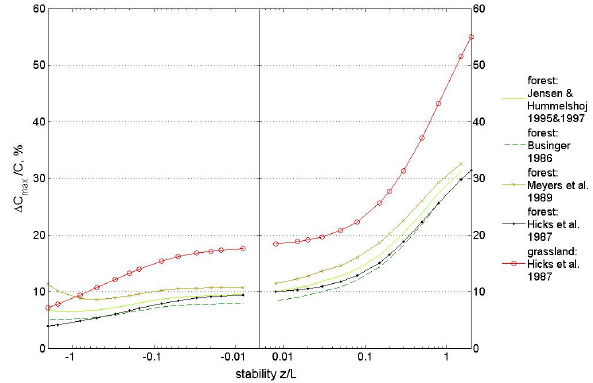
Fig. 2. Minimal relative precision requirements ( 1C max / C in %) assuming a maximum HNO 3 deposition flux ( R c =0) for a grassland site (NEU) and a forest site (EGER). For the forest site different pa- rameterizations for R b existing in literature (Businger, 1986; Jensen and Hummelshoj, 1995, 1997; Meyers et al., 1989) are